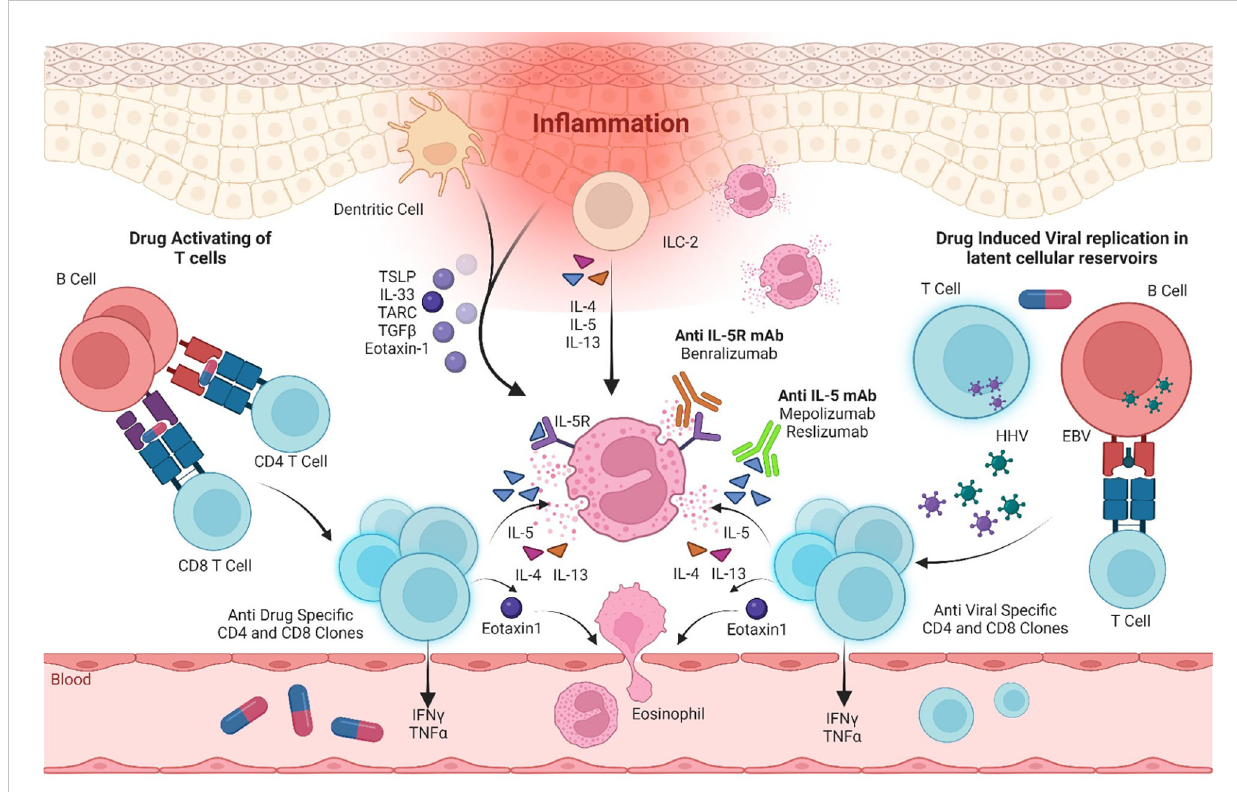
FIGURE 1 Immunological pathways in DRESS pathogenesis and immunotherapy targeted inhibition of the IL-5 axis. IL, interleukin; IL-5R, interleukin-5 receptor; mAb, monoclonal antibody; EBV, Epstein – Barr virus; HHV, Herpesviridae virus; ILC-2, Type 2 innate lymphoid cells; TSLP, thymic stromal lymphopoietin; TARC, thymus- and activation-regulated chemokine; TGF b , transforming growth factor b ; IFN- g , interferon g ; TNF a , tumor necrosis factor a